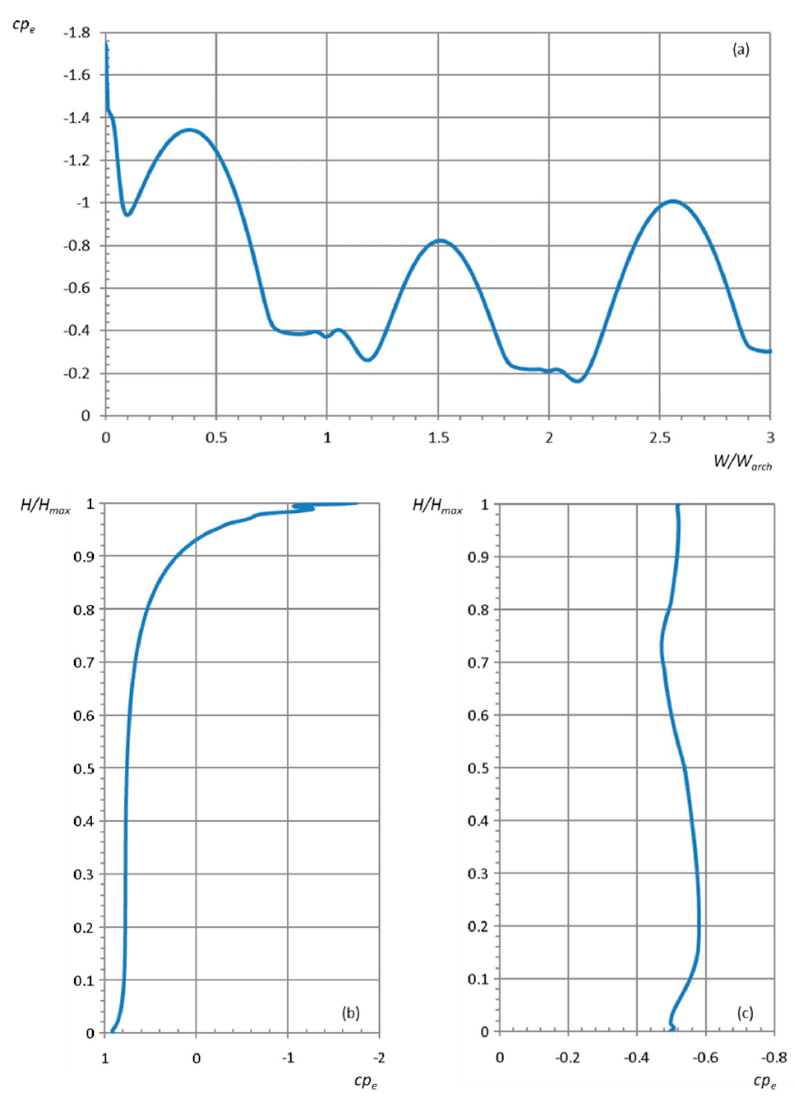
Figure 18. Wind external pressure coefficients determined through CFD for the multi-tunnel greenhouse: ( a ) roof; ( b ) left lateral column; ( c ) right lateral column.